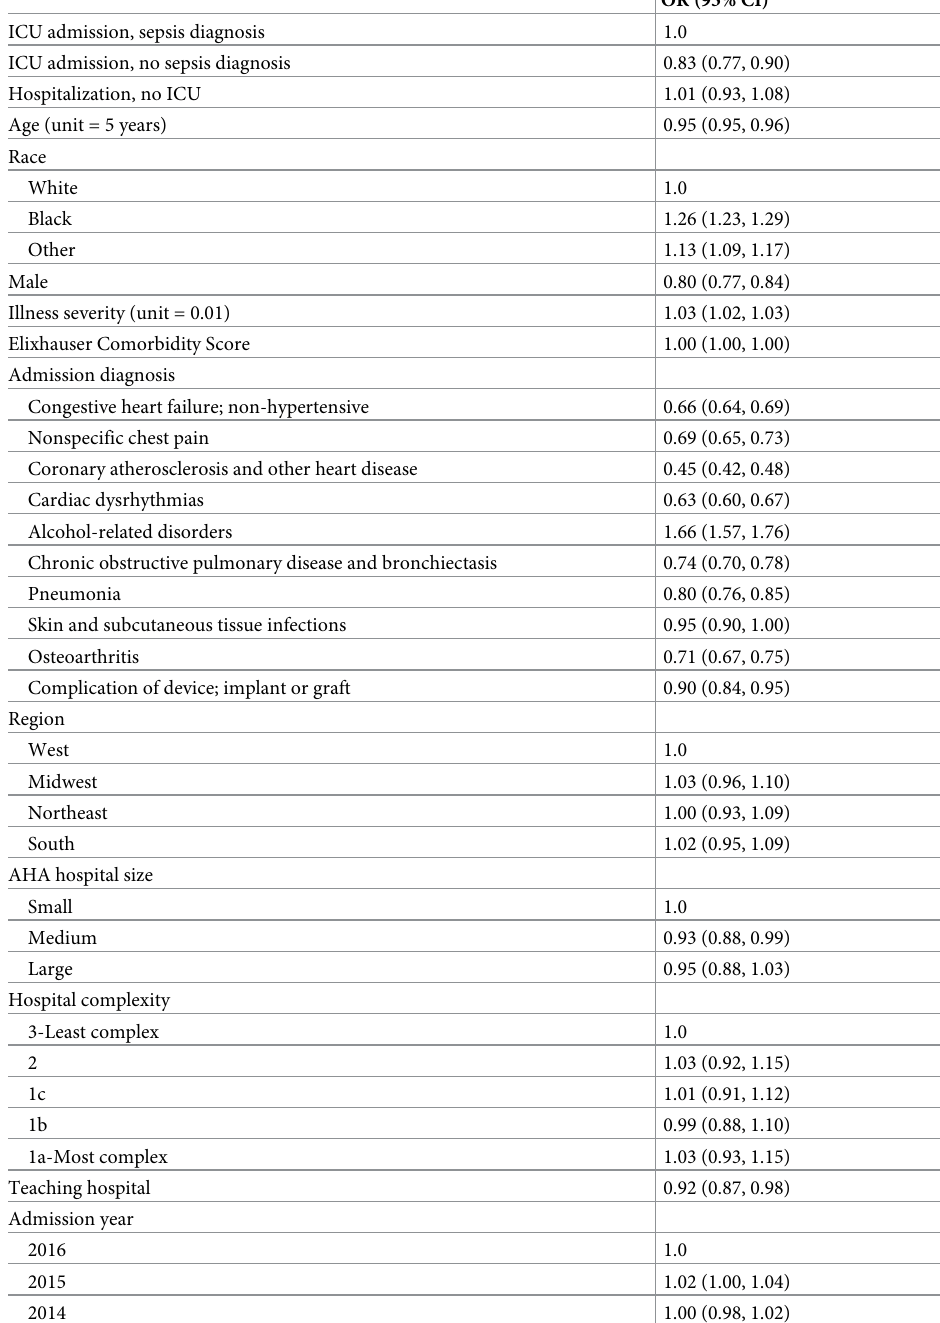
Table 2. Statin discontinuation at six-months